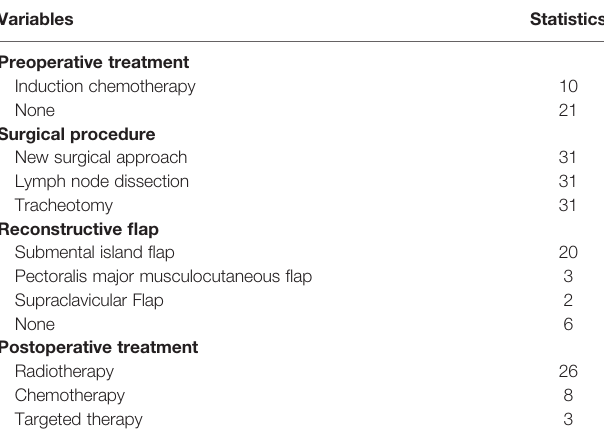
TABLE 2 | Clinical treatment of study populations.